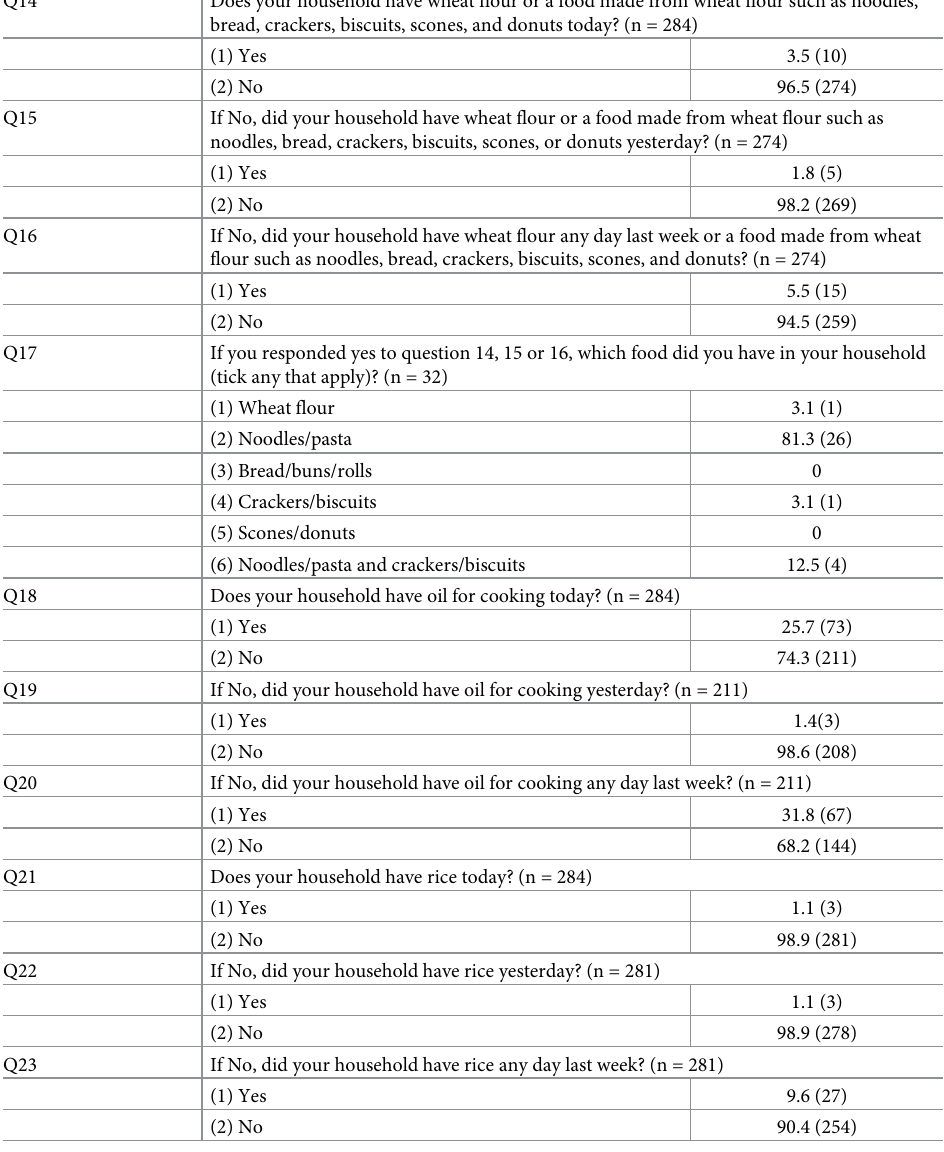
Table 4. Responses on use of industrially processed